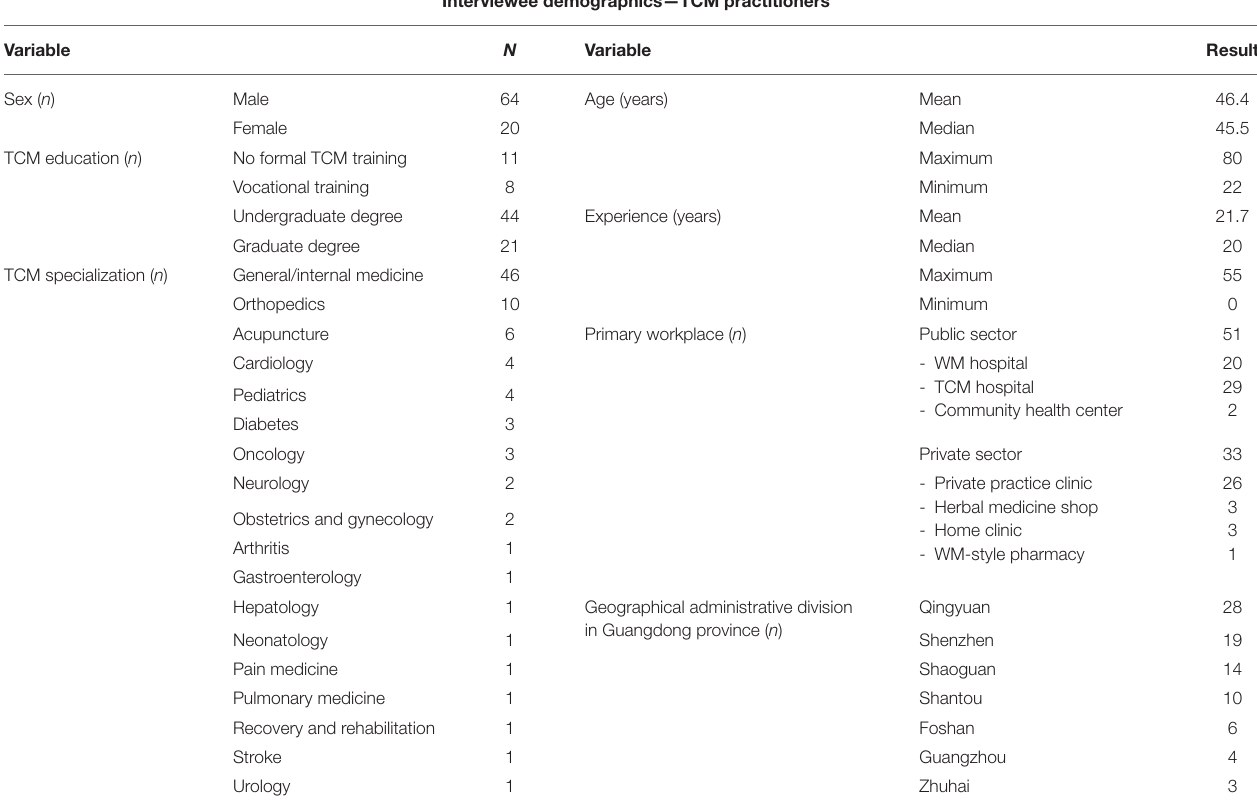
TABLE 1 | Demographic characteristics of our sample of TCM